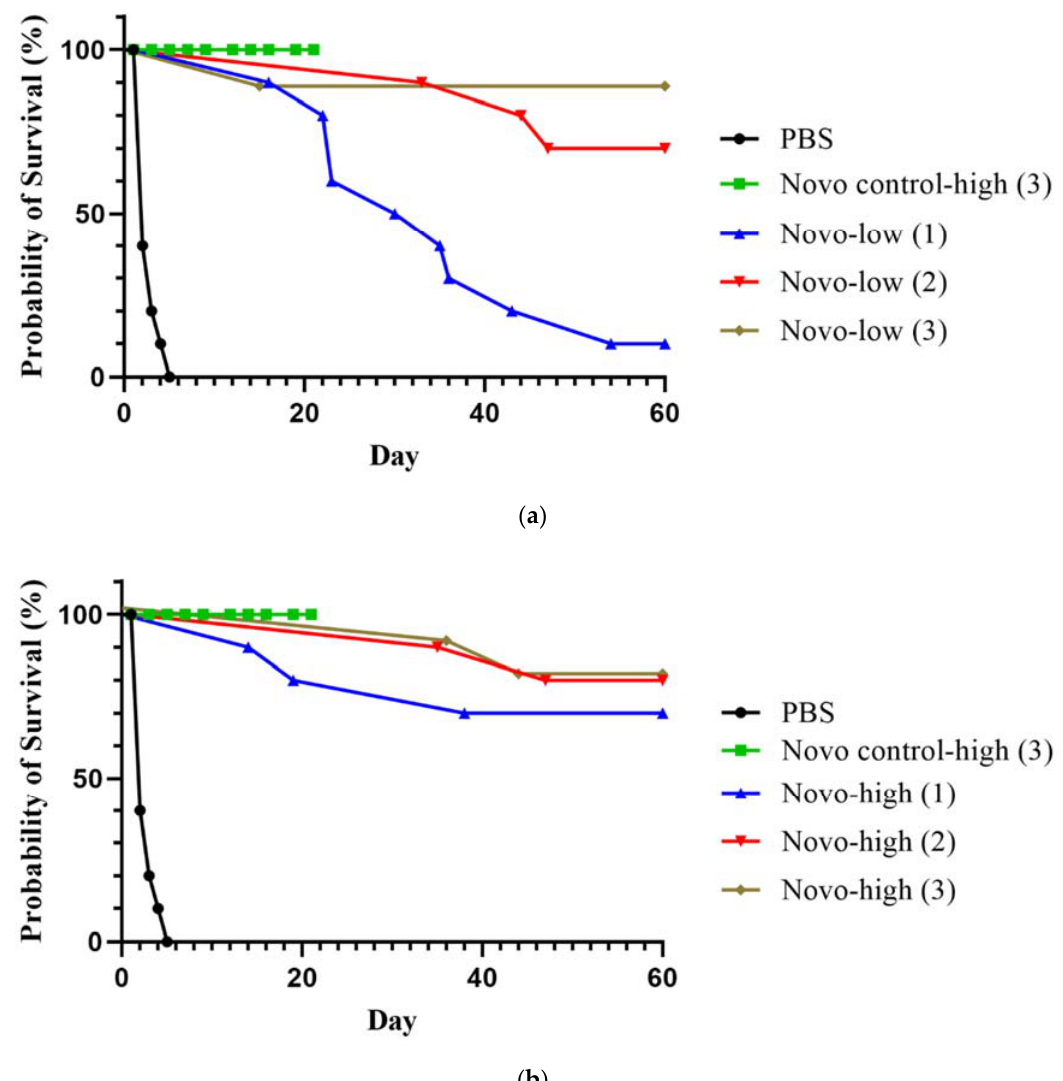
Figure 2. BALB/c mice infected by the IP route with B. pseudomallei and treated with Novo. The mice were challenged with approximately 2.0 × 10 5 CFU Bp K96243 (5.7 LD 50 ). One, 2, or 3 doses of Novo were given post-challenge (1 h, 1 h and 8 h, or 1 h, 8 h, and 24 h). The survival results are shown for animals given a low dose of Novo, 1.25 mg ( a ), or a higher dose, 2.5 mg ( b ). Survival was monitored for 60 days. All groups contained 10 mice.